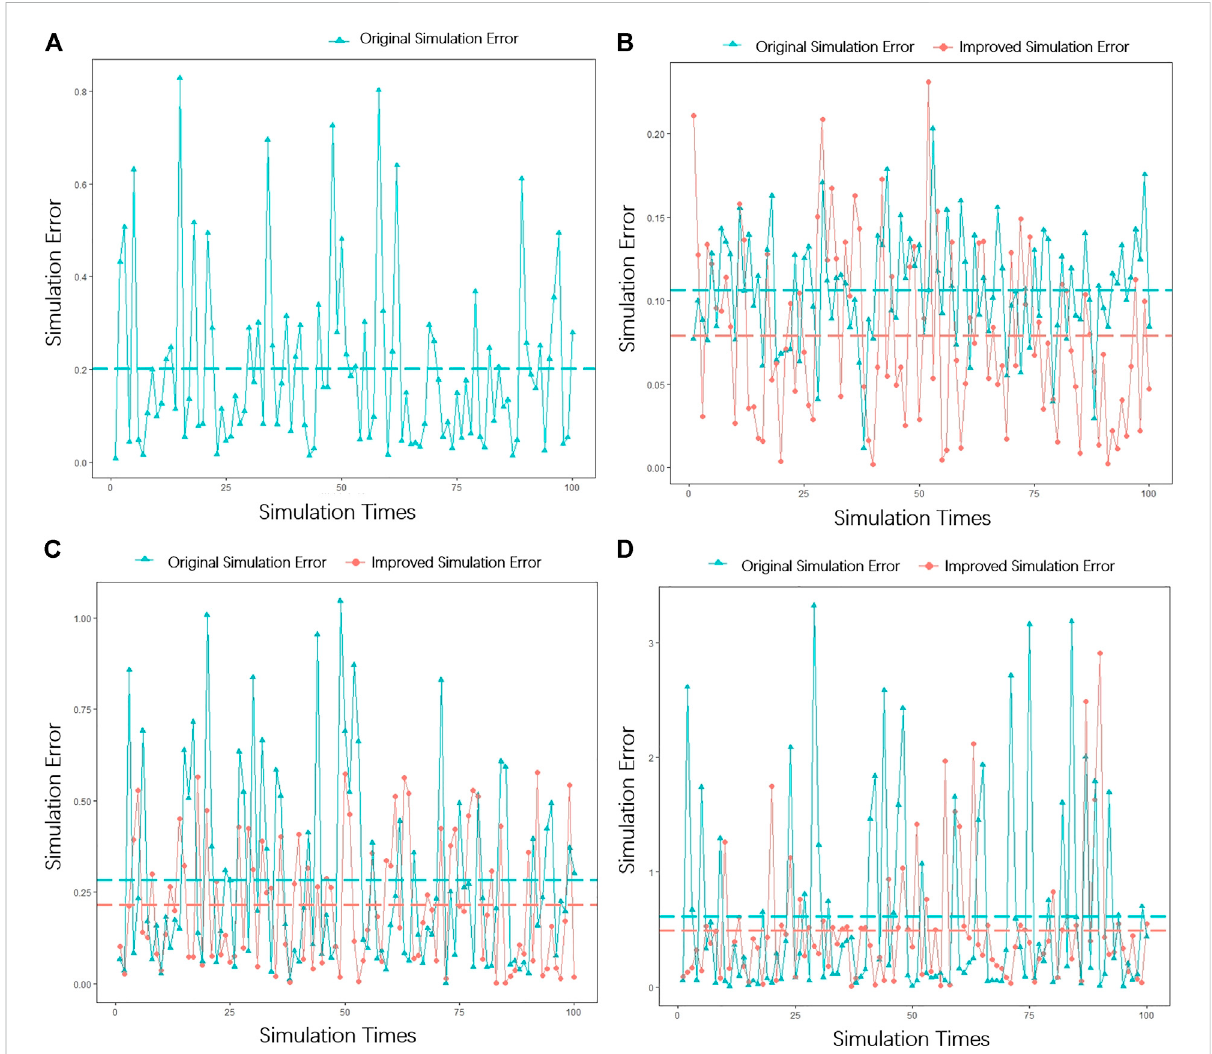
FIGURE 6 Scatter plotof simulation error. Panel (A) , (B) , (C) , and (D) correspondsto thescatter plotofsimulationerror of tweet(a),(b), (c),